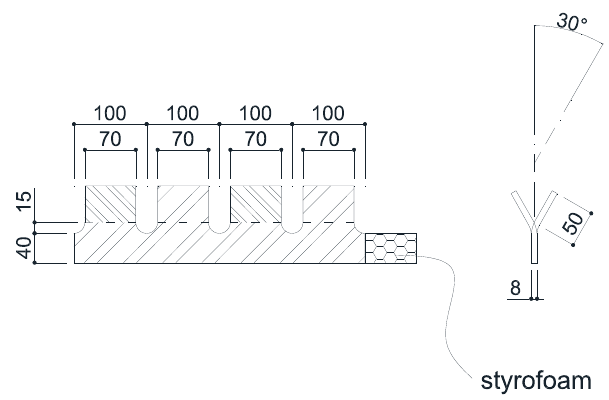
Figure 1. Dimensions of Y-type perfobond rib shear connector (unit: mm). Materials 2017 , 10 , 1340